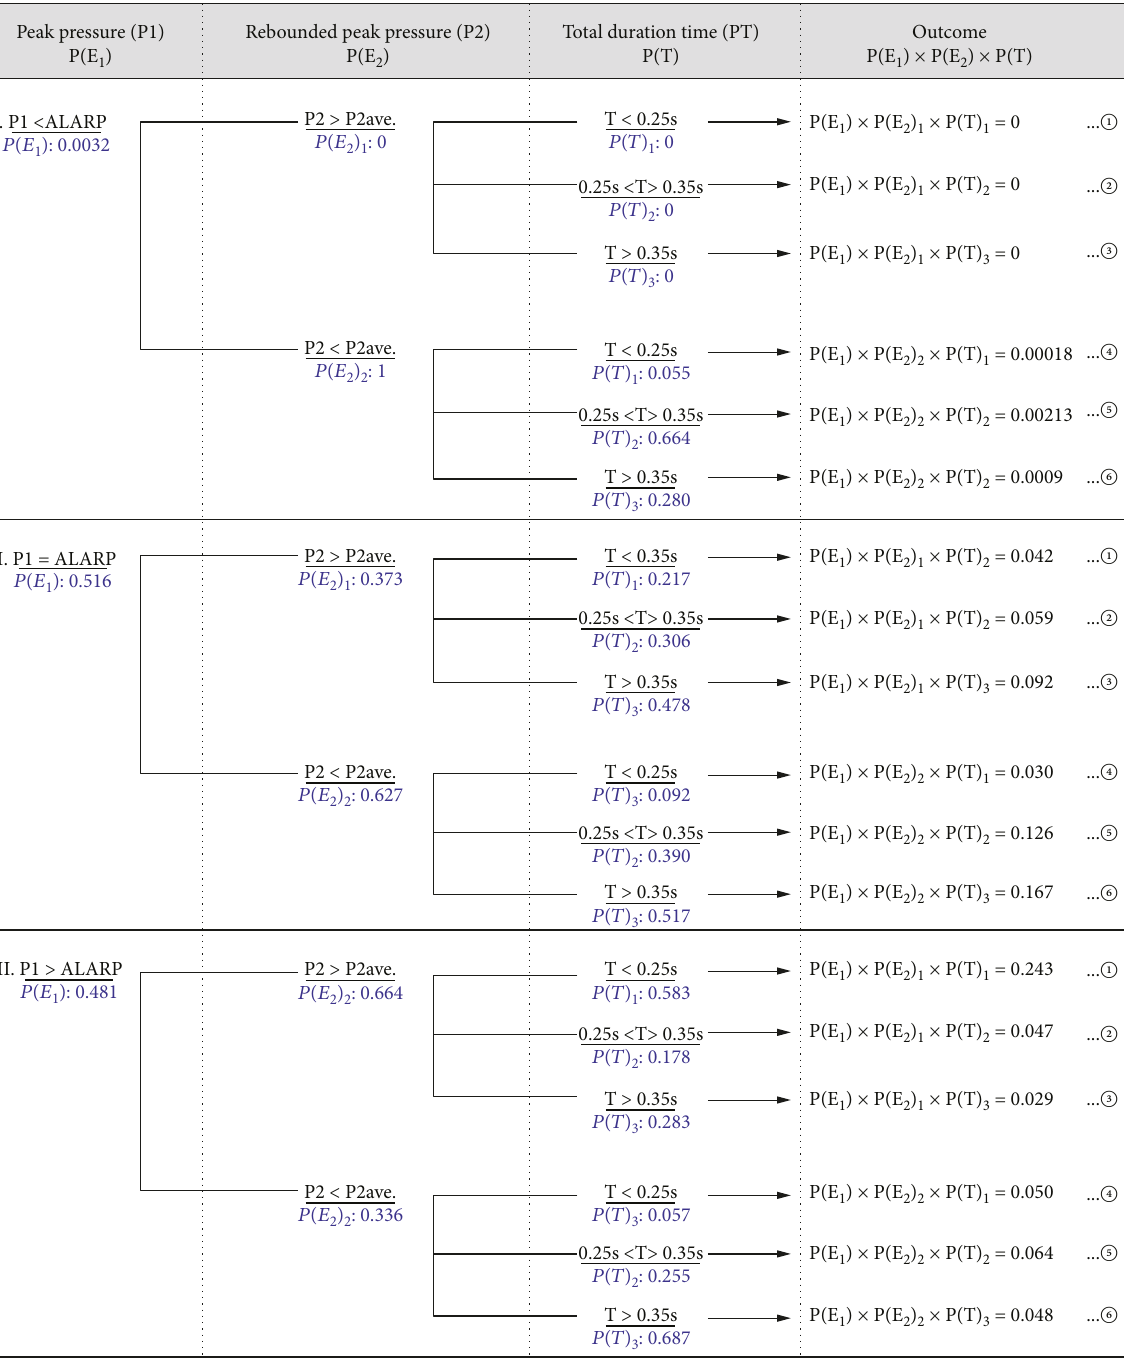
Figure 10: Event tree analysis for explosion pressure considering both positive- and negative-phase